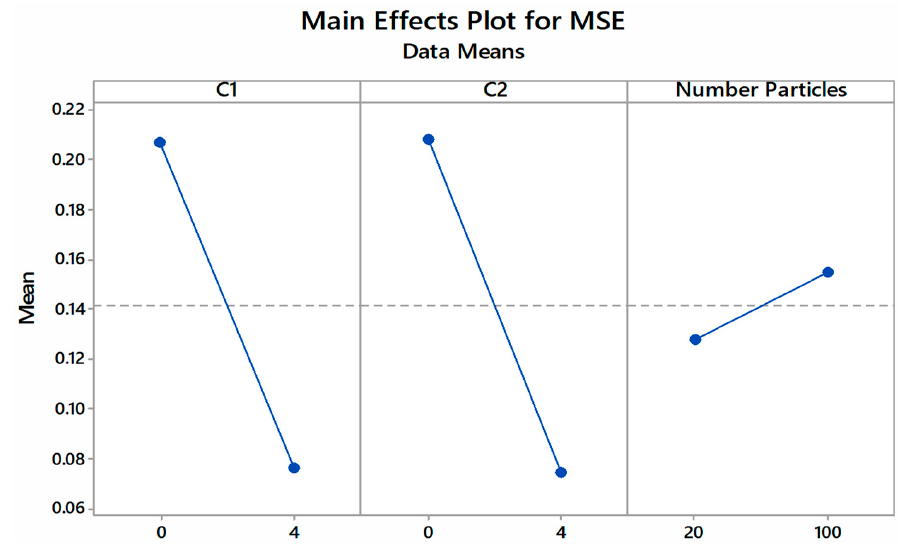
Figure 4. Main effects of PSO parameters against fitness value.